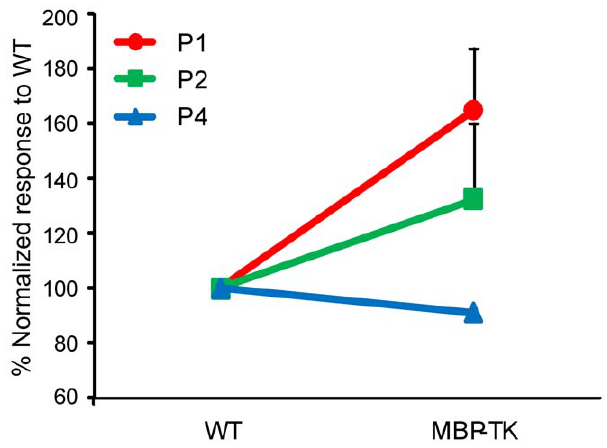
Figure 4. Normalized responses of MBP-TK versus WT slices. The MBP-TK data were acquired from the same batch of experiments as for WT littermates. Data are represented as mean 6 SE. MBP-TK cerebellar neurons at P1–P2 show a trend toward increased excitability with respect to WT neurons; by P4 this trend is inversed and neurons are less excitable. The VSD response of P1 and P2 MBPTK slices was significantly higher than that of WT slices (P=0.048, n=6 slice pairs), while responses of P4 MBPTK slices were significantly lower than control slices (P=0.03, n=4 slice pairs). Note: the error bar for the P4 responses is small and thereby not visible in the